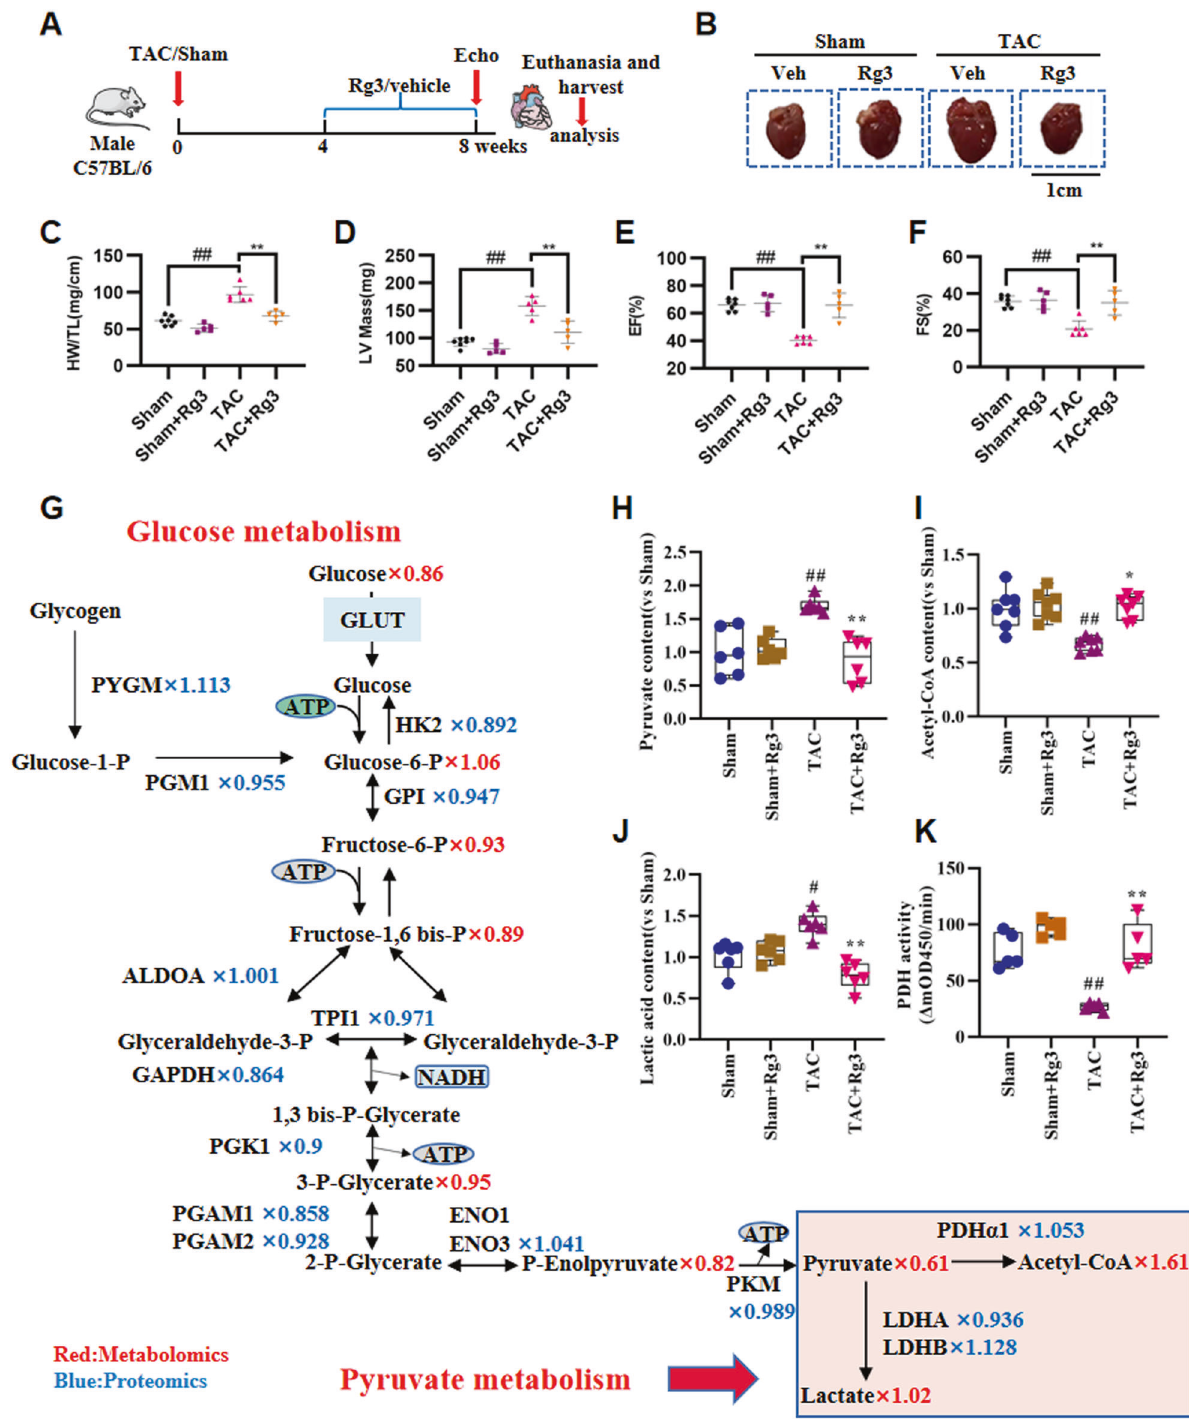
Fig. 1 Rg3 Protects Mice from TAC-Induced Cardiac Hypertrophy and regulates pyruvate metabolism. A Schedule of animal treatments. Mice were subjected to TAC for 4 weeks, vehicle or Rg3 (20 mg/kg) was administered to TAC mice on the fourth week after surgery, and maintained by one administration per day for 4 weeks. B Image of the whole heart. C Heart weight to tibia length ratio, n = 5 – 8 for each group. D – F Quanti fi cation of left ventricular (LV) mass index ( D ), ejection fraction (EF%) ( E ), and fractional shortening (FS%) ( F ), n = 5 – 8 for each group. G Reconstruction of glucose metabolism from omics data. The identi fi ed proteins via proteomics and metabolomics were colored differently. The numbers in metabonomics and proteomics represented the change ratio of metabolites or enzymes of Rg3 treated compared with TAC group. H – J The contents of pyruvate, acetyl CoA, and lactate in heart tissue, n = 6 for each group. K The activity of pyruvate dehydrogenase in heart tissue, n = 5 for each group. All data were analyzed using one-way ANOVA and were expressed as means ± SD, # p < 0.05, ## p < 0.01 versus Sham group, * p < 0.05, ** p < 0.01 versus TAC group.